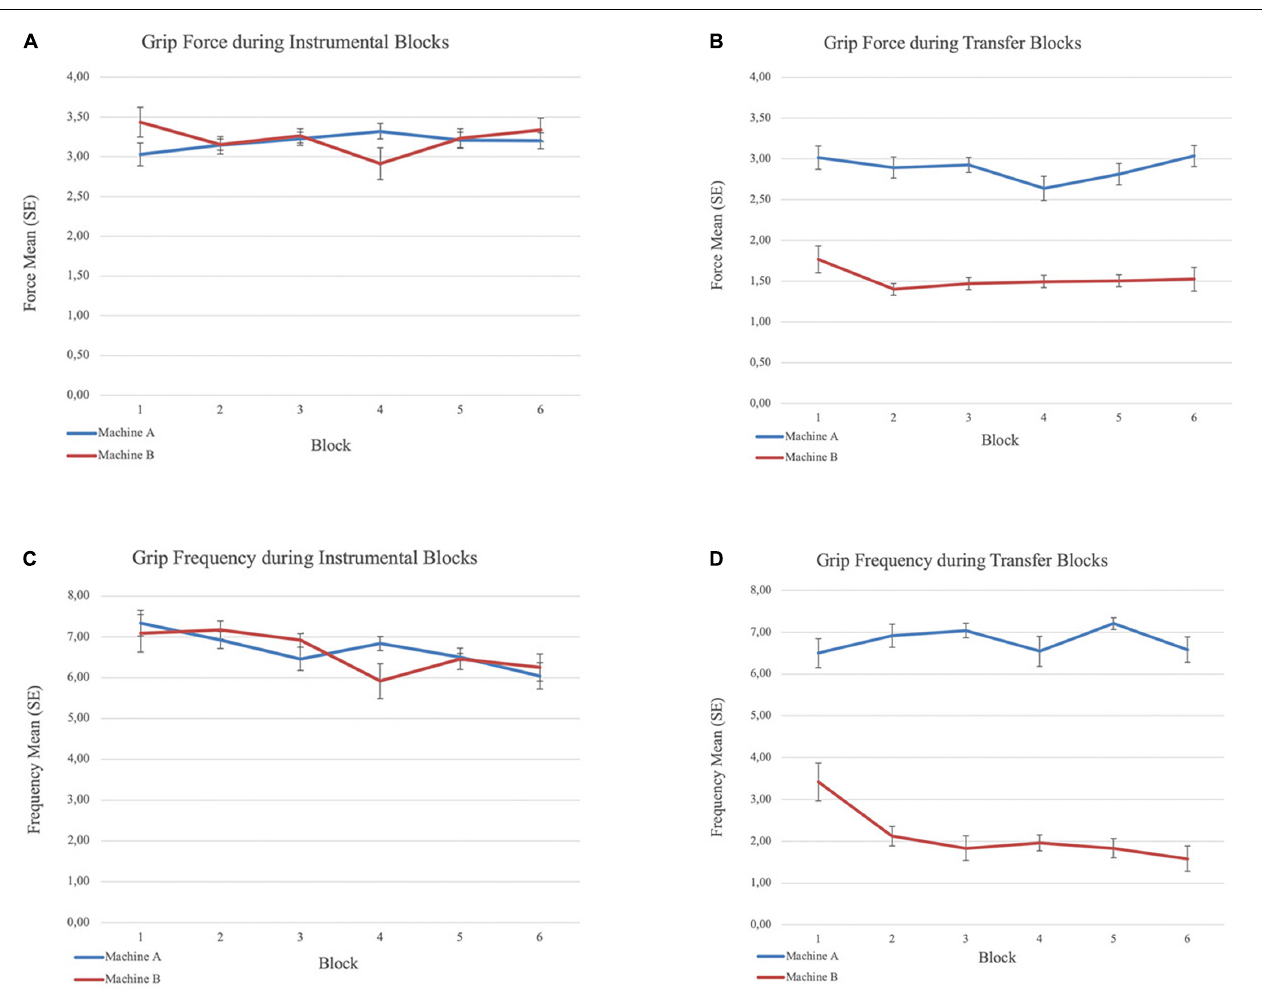
FIGURE 2 | Grip force and frequency means and standard errors (within-subject) during the instrumental and transfer phases. (A) Mean grip force across blocks during instrumental phase. (B) Mean grip force across blocks during transfer phase. (C) Mean grip frequency across blocks during instrumental phase and (D) Mean grip frequency across blocks during transfer